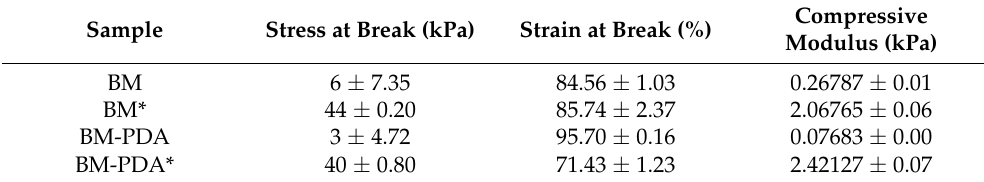
Table 3. The mechanical properties of BM and BM-PDA pristine and mineralized cryogels. Sample Stress at Break (kPa) Strain at Break